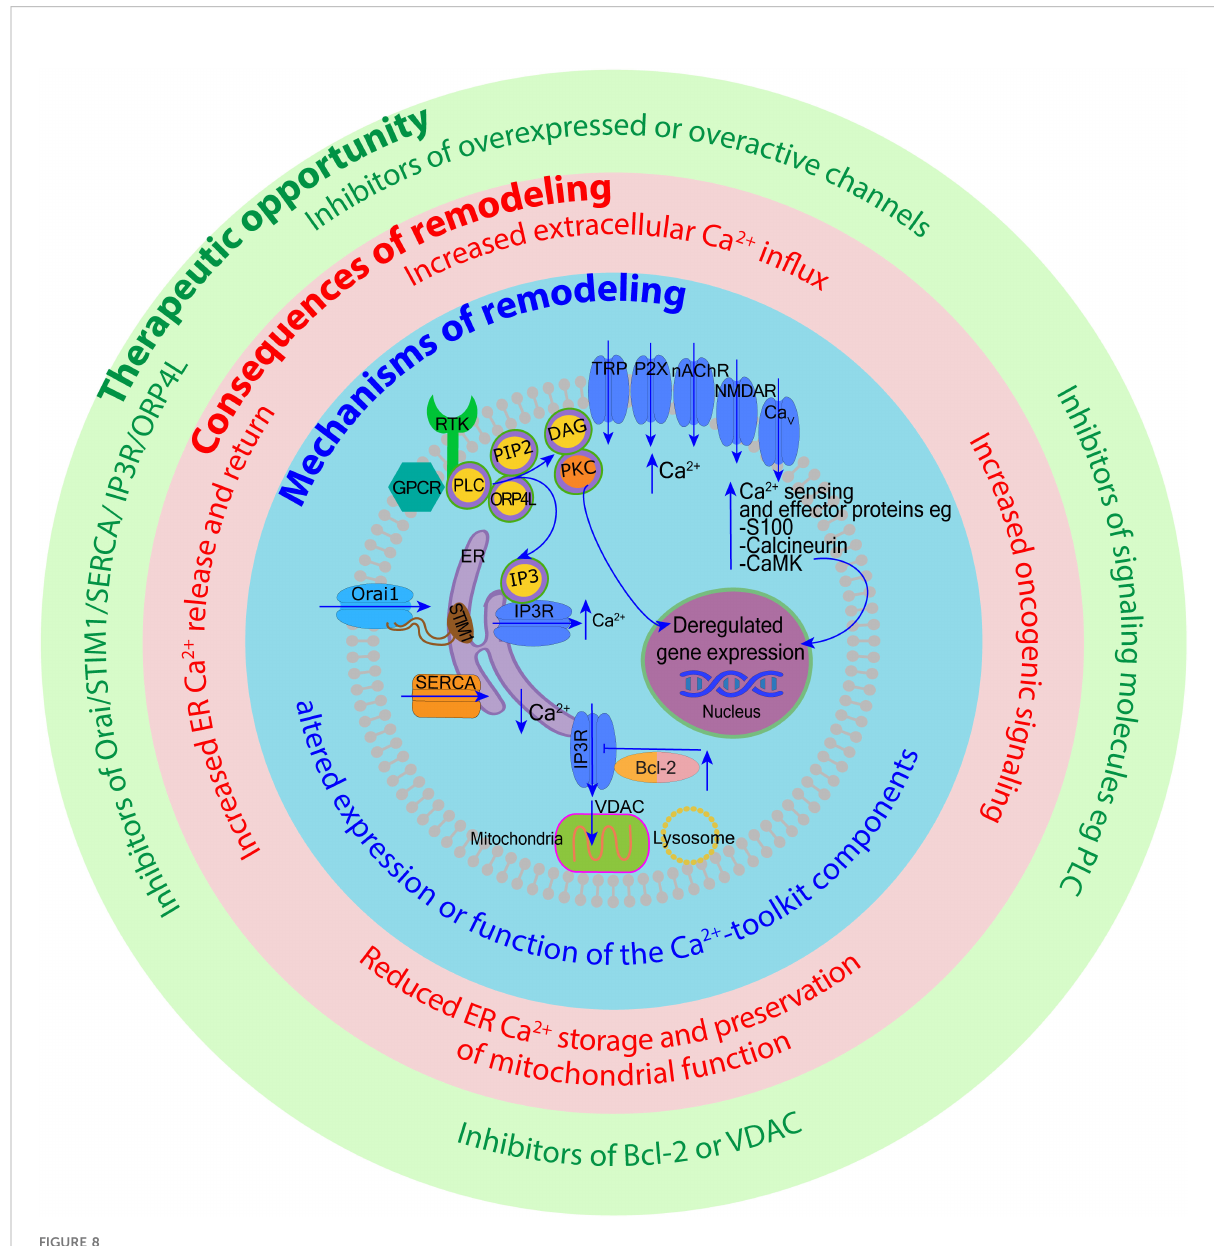
FIGURE 8 Remodeling of calcium signaling in hematologic cancers and therapeutic opportunities this presents. Examples of mechanisms responsible for the remodeling of Ca 2+ signaling in blood cancer are depicted within the central blue circle. Their direct consequences are listed in the middle red circle, and therapeutic opportunities arising from these changes are highlighted in the outer green circle. For example, the increased expression of the plasma membrane Ca 2+ channels (a mechanism of remodeling) leads to increased extracellular Ca 2+ in fl ux supporting oncogenic signaling (a consequence). Such changes could be counteracted by speci fi c Ca 2+ channel inhibitors (a therapeutic opportunity). In another example, mechanisms that spare cancer cells from mitochondrial Ca 2+ overload (e.g. through the overexpression of Bcl-2 or VDAC) could be counteracted by inhibitors of these molecules. The design of novel therapies heavily relies on our understanding of the Ca 2+ -toolkit remodeling in different blood